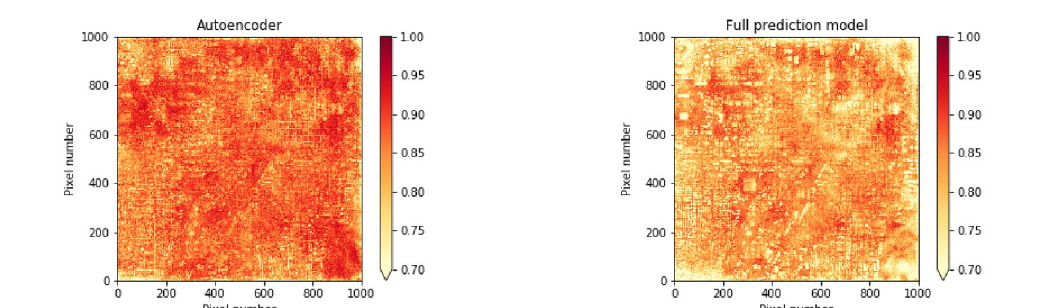
(a) Correlations between the true images and the decoder reconstruction (b) Correlations between the true images and ABM predictions (bot- (not ABM) for each pixel. The mean correlation value is 0.86. The tleneck + corrector + decoder) for each pixel. The mean correlation minimum correlation value in apixe l is 0.18, and the maximum is 0.98. value is 0.82. The minimum correlation value in a pixel is 0.20, and the maximum is 0.95. Figure 4. Mean pixel-level correlation values between the ground truth and predicted images for 300 test cases. The correlation shown per pixel is the average of the three channels per the bottleneck model error plus the corrector error. Figure 4 shows the pixel-level Pearson correlation between truth and predicted images for 300 test cases. Note that the model has never seen test cases during training. Fig- ure 4a shows the correlations between the autoencoder predictions and the corresponding ground truth images, while Fig. 4b shows the correlation between the ABM and the corresponding ground truth images. The figures show that the performance is good throughout the spatial domain, with almost all the pixels having correlations higher than 0.9, except for the smaller correlations near the lower-left and upper-right corners. The mean cor- relation value is larger than 0.8 in both figures. Observe that the correlations in Fig. 4b are lower than those in Fig. 4a as expected. Qualitative ABM performance assessment. This section shows qualitative results and quantitatively assesses the model performance using two conceptually different metrics. Figure 5 shows, in each row, predic- tions for a randomly selected test case (six cases total). In the first column, the four scalar inputs are depicted by the green cross symbolizing the location of the source release and a wind vector arrow that shows the wind’s speed (arrow length) and direction (arrow direction). The second column shows the latent space associated with each case predicted by the bottleneck model. The third column shows the corrected latent space. The fourth column shows the overall ABM predictions. Finally, the fifth column shows the ground truth images. A comparison between the bottleneck model output (column two) and the corrector model output (column three) in Fig. 5 suggests that the corrector’s main contribution is to removing noise in the white areas. A com- parison between the last two columns in Fig. 5, ABM model prediction (fourth column) and ground truth (last column), shows outstanding performance. Quantitative ABM performance assessment. In this section, the ABM performance was compared against two models. (i) The reference model, which is not a trained model, takes the source location and wind velocity as inputs and returns random patterns from the training data. This model can be interpreted as the diagonal line on a receiver operating characteristic (ROC) 42 curve. (ii) The baseline model, K-nearest neigh- bor (KNN) 38 approach using a single neighbor (K = 1). KNN approach identifies the closest input conditions between the desired input and the training inputs using the Euclidean distance. The KNN approach prediction is the spatial pattern associated with the closest input conditions within the training dataset. The performance was assessed using two metrics. (i) The normalized root mean squared error (NRMSE), which considers all image pixels in the error calculation and is a metric commonly used for computer vision and image recognition applications because it gives an overall performance metric, and (ii) the figure of merit in space (FMS) 43 , which is widely used in atmospheric sciences because it mainly focuses on how well the model predicts spatial patterns. FMS is also known as Jaccard index 44 and intersection over union criterion 45 . FMS only assesses how well non-white pixels (binary spatial pattern), between the true image and the predicted image, overlap, making it highly sensitive to rotations 46 . RMSE, which considers the magnitude values instead of binary ones, as FMS does, was included as a metric to have a more comprehensive measure of how the model performs throughout the domain. These two metrics complement each other giving a comprehensive performance score for the model. Equation (1) shows how the NRMSE is calculated for a pair of predicted and true images (case i ) where � · � 2 denotes the l 2 -norm. A perfect prediction would have an NRMSE of 0. Figure 6a shows the NRMSE histograms for the ABM, the baseline model, and the reference model. The histograms were built considering the 300 cases set aside for testing purposes. The figure includes the mean NRMSE for the three models: 8% RMSE for the ABM, 12% for the baseline model (KNN approach), and 22% for the reference model (random plume). NRMSE considers white pixels, that is, pixels where no deposition exists. The images in our dataset are approximately 85% white pixels; hence even if the prediction and the true pattern do not overlap, they still have around 70% of matching pixels explaining the mean NRMSE for the reference model (random plume) being only 22%.